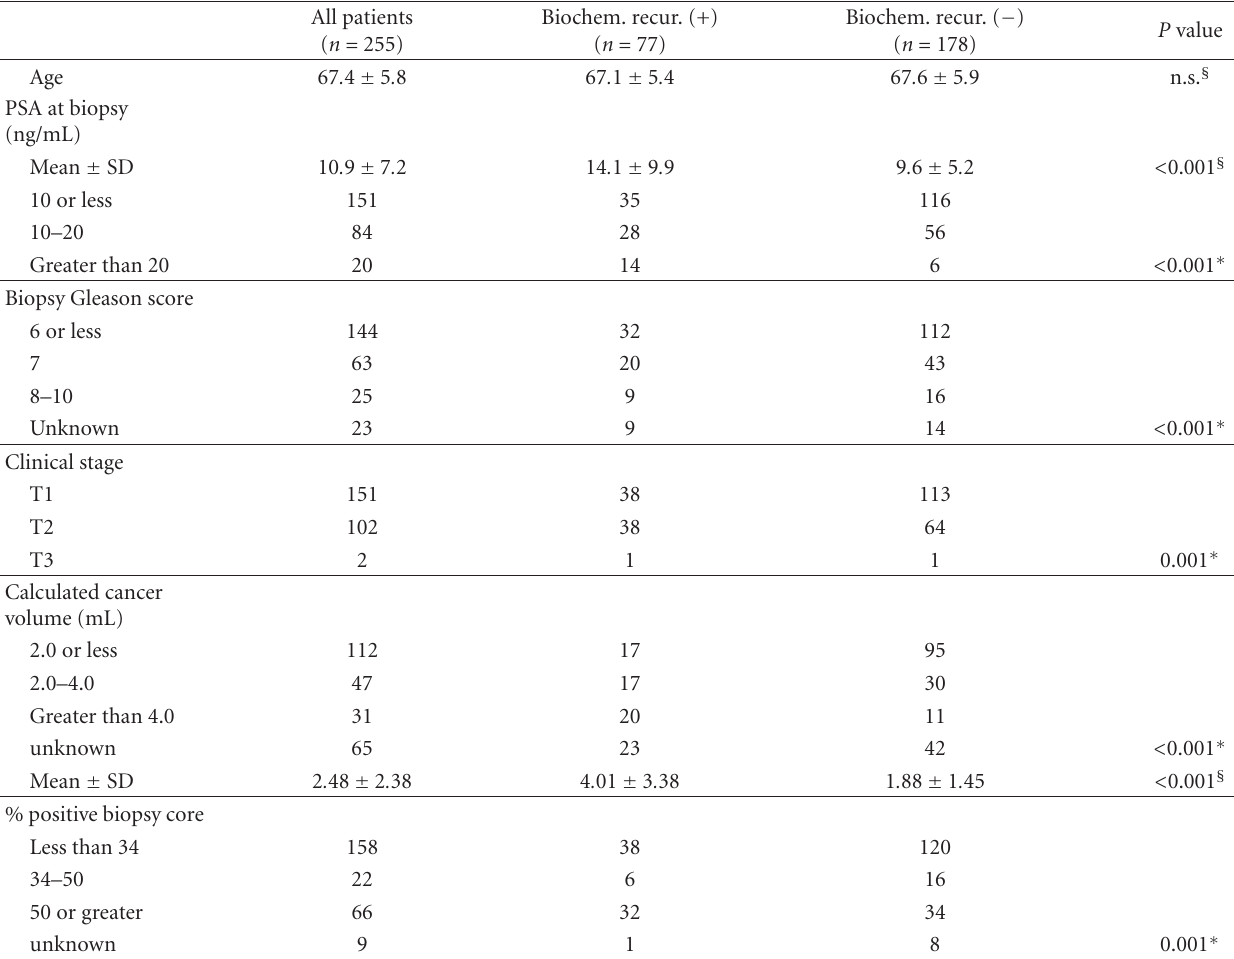
Table 1: Preoperative clinicopathological